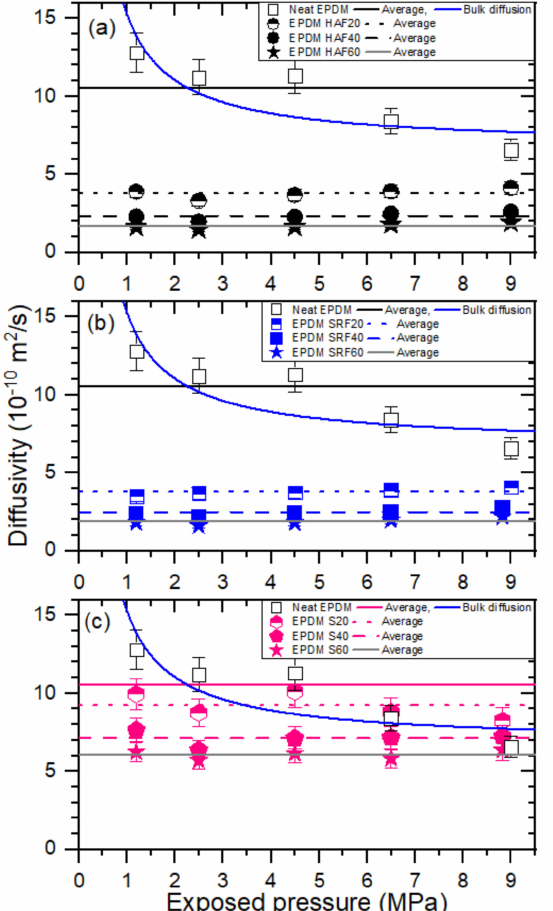
Figure 6. Hydrogen diffusivity ( D ) versus exposed pressure for the ( a ) EPDM HAF series, ( b ) EPDM SRF series and ( c ) EPDM S series. The blue line for neat EPDM represents the result of bulk diffusion fitting. The horizontal lines for neat EPDM and blended EPDMs containing filler represent the average diffusivity. The same scale on the x-axis and y-axis is presented for comparison.